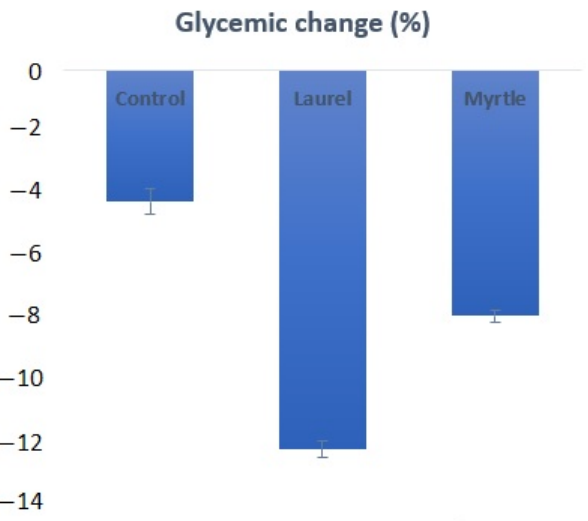
Figure 10. The effect of laurel and myrtle EO application on glycolytic change (%) in rat. Female rats ( n = 5) were administered ig with laurel and myrtle EOs at a dose of 1 µ L per 1 g of rats once daily for 14 days. Laurel and myrtle EOs were mixed with sunflower oil (1:1) and the total daily volume per rat was 0.5 mL. The control group was treated ig with 0.5 mL of sunflower oil. The results are expressed as the mean value of each experimental group ± SEM.